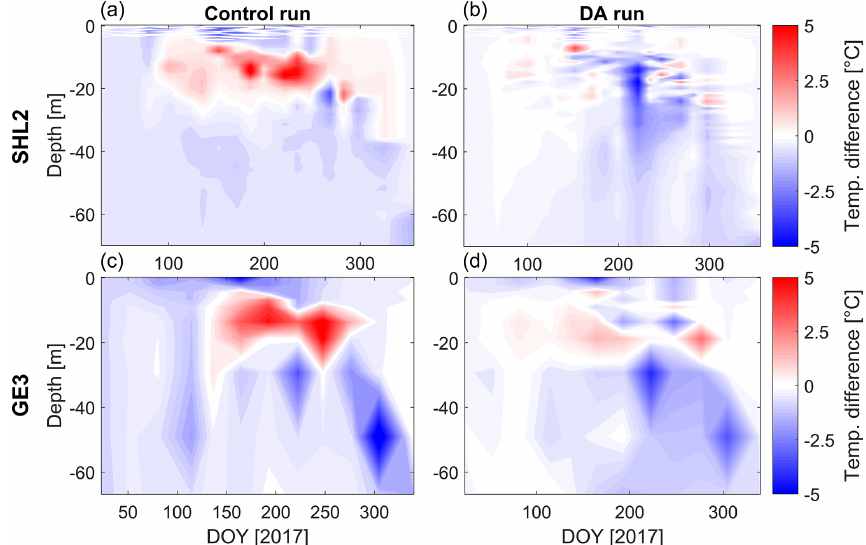
Figure 7. Evolution of the deepwater temperature without and with DA. (a, c) The differences of control runs minus in situ observations; (b, d) the differences of DA runs minus in situ observations. Panels (a–b) correspond to the center of the main basin (SHL2; Fig. 1), and panels (c–d) correspond to Petit Lac (GE3; Fig. 1).